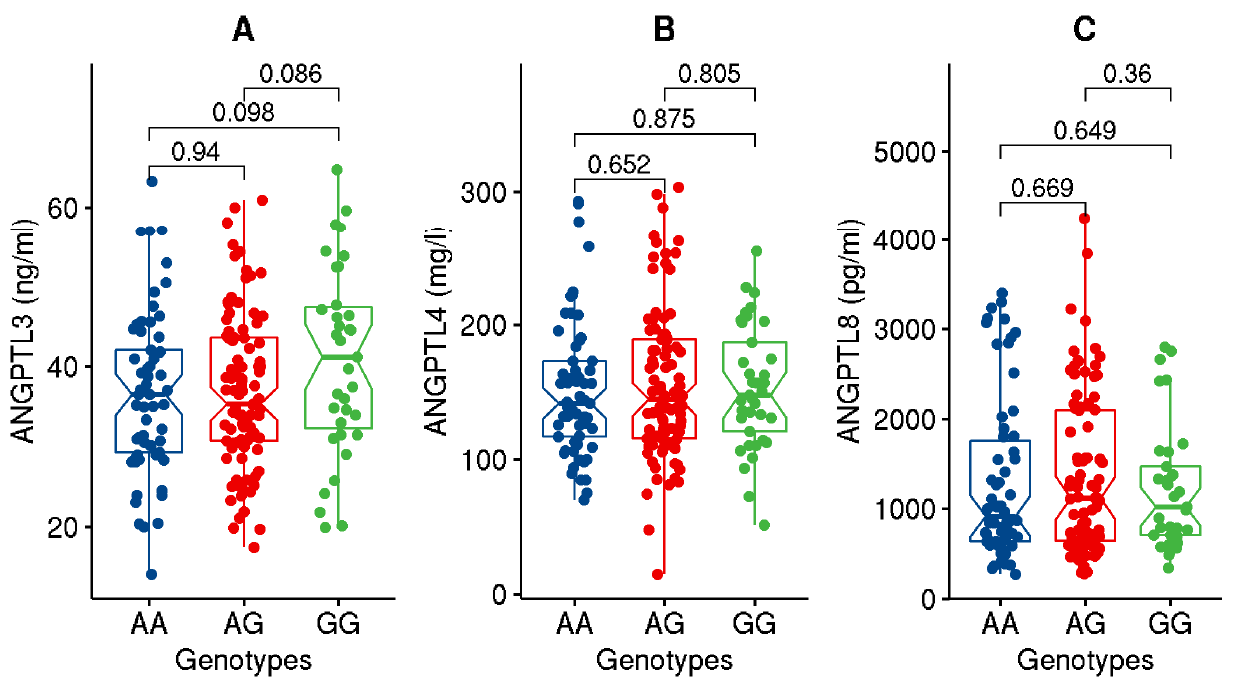
Figure 3. Data distribution for the levels of ANGPTL’s, namely ANGPTL3 ( A ), ANGPTL4 ( B ), and ANGPTL8 ( C ), in individuals with genotypes homozygous for major allele (AA) versus genotypes homozygous for effect allele (GG) or for the heterozygous genotypes (AG). The boxplot illustrates minimum and maximum values in the range, first quartile, median, and third quartile for each of the genotype groups.